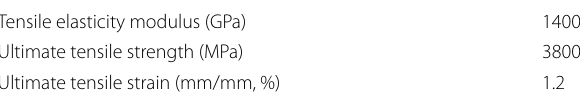
Table 6 CFRP wraps